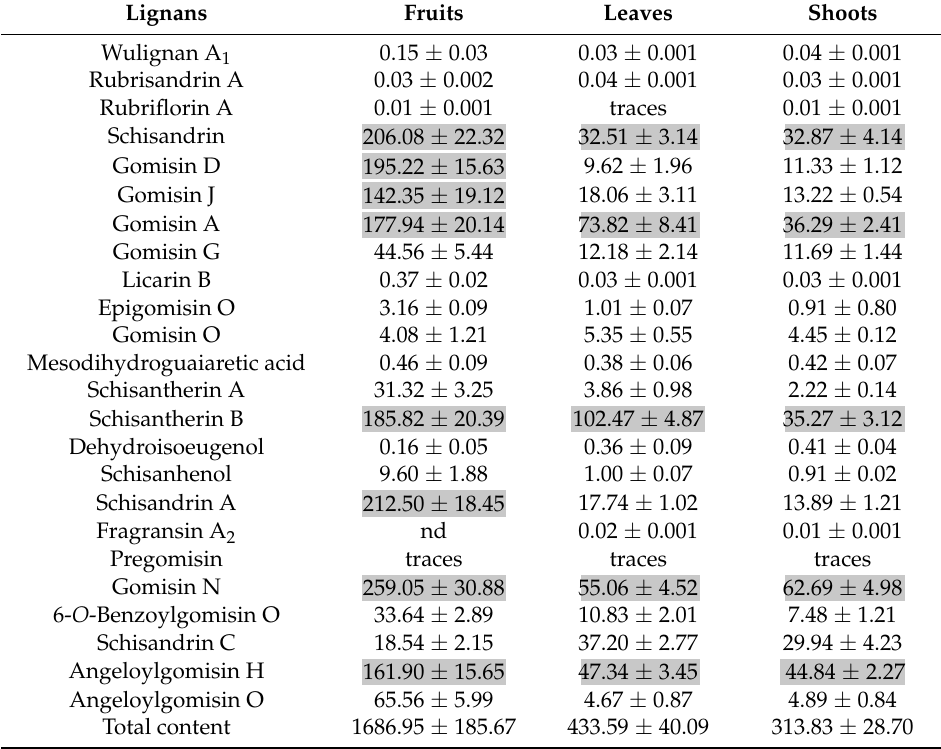
Table 2. The lignan contents (mg/100g DW) ± SD ( n =5) in fruit, leaf and shoot extracts of Schisandra chinensis . Fruits Leaves